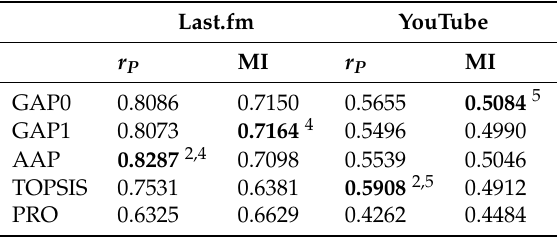
Table 3. Pearson correlation ( r P ) and Mutual Information (MI) measures of similarity between the target variables (Last.fm artist plays, YouTube channel views) and the aggregation methods (AAP, GAP0, GAP1, TOPSIS, PRO) on 2 April 2019. With bold letters, we denote the best value per similarity measure and target variable. With the exponents, we denote the best similarity scores for which their difference from the 2nd, 3rd, 4th, or 5th best, respectively, is statistically significant (95% confidence). For r P , the first number in the exponent concerns Zoo’s method, while the second concerns the randomization